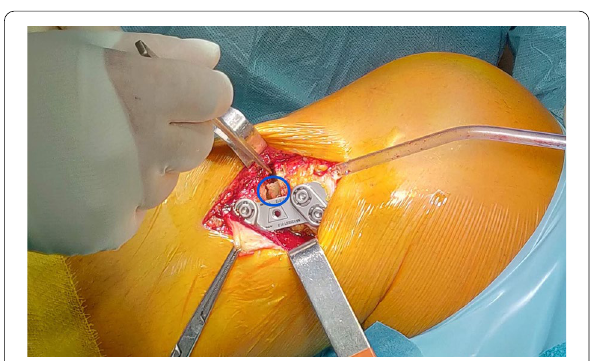
Fig. 8 Intraoperative finding of the Puddu plate positioned and fixed on the posteomedial aspect of the main horizontal osteotomy site, from medial view. The cancellous bone bract detached from both the proximal and distal sides of the site of osteotomy to create a bridge of bone contact that favors healing of the fracture can be seen in the